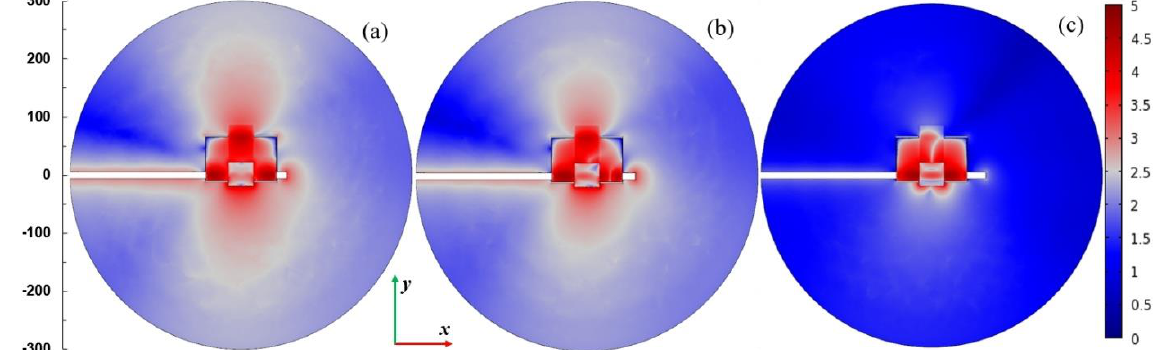
Figure 14. Dependence of power ratio on movable plunger position for closed configuration.